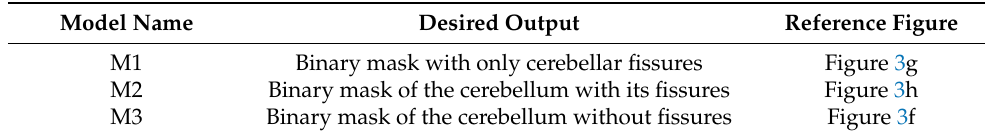
Table 1. Differences between the three used